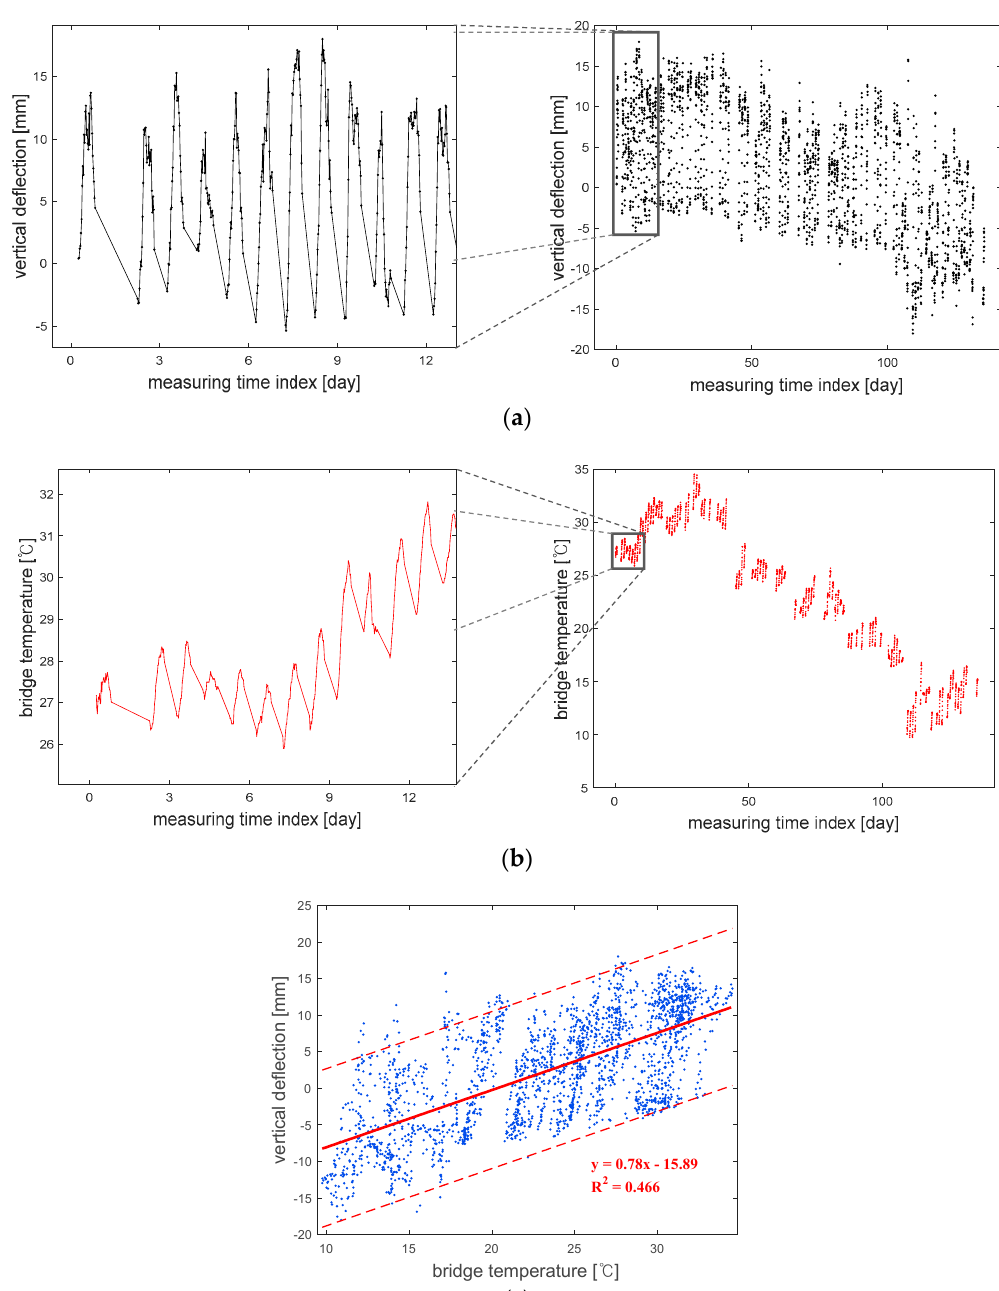
Figure 4. Measurement data: ( a ) vertical deflection; ( b ) bridge temperature; ( c ) bridge temperature versus vertical deflection.